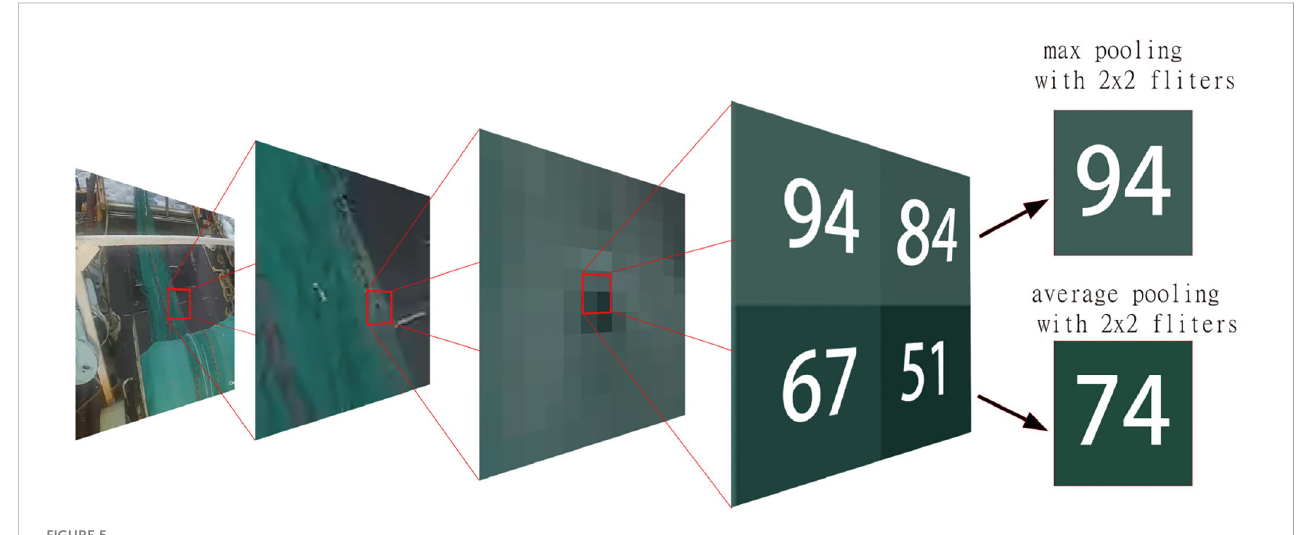
FIGURE 5 Demonstration of max pooling and average pooling.